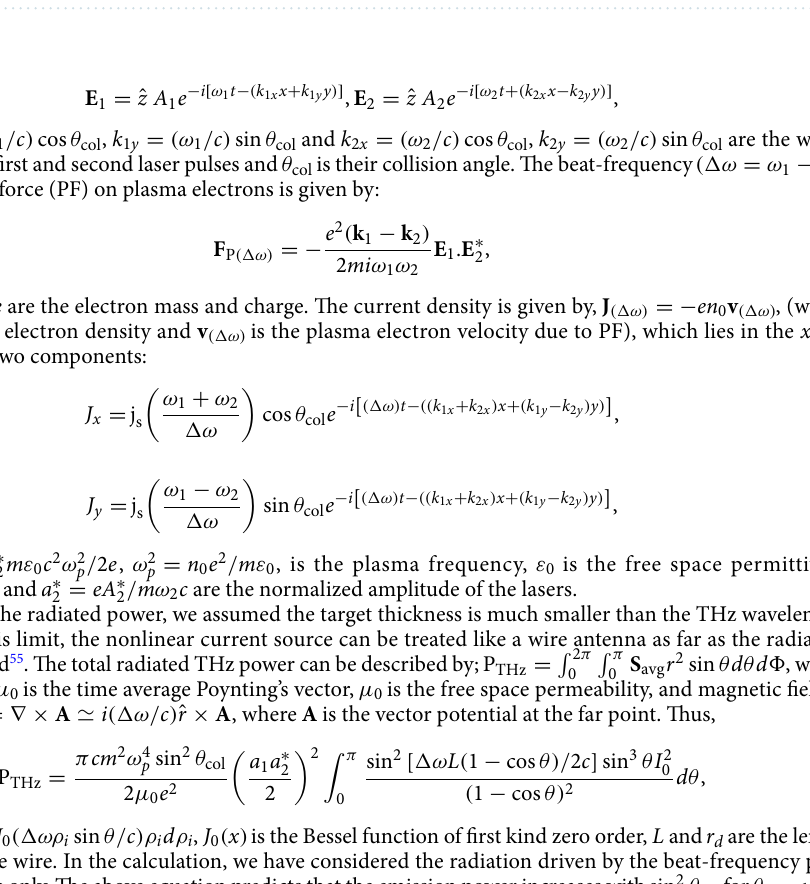
10 µ m . ( b ) Power of THz emission with beat- = ±